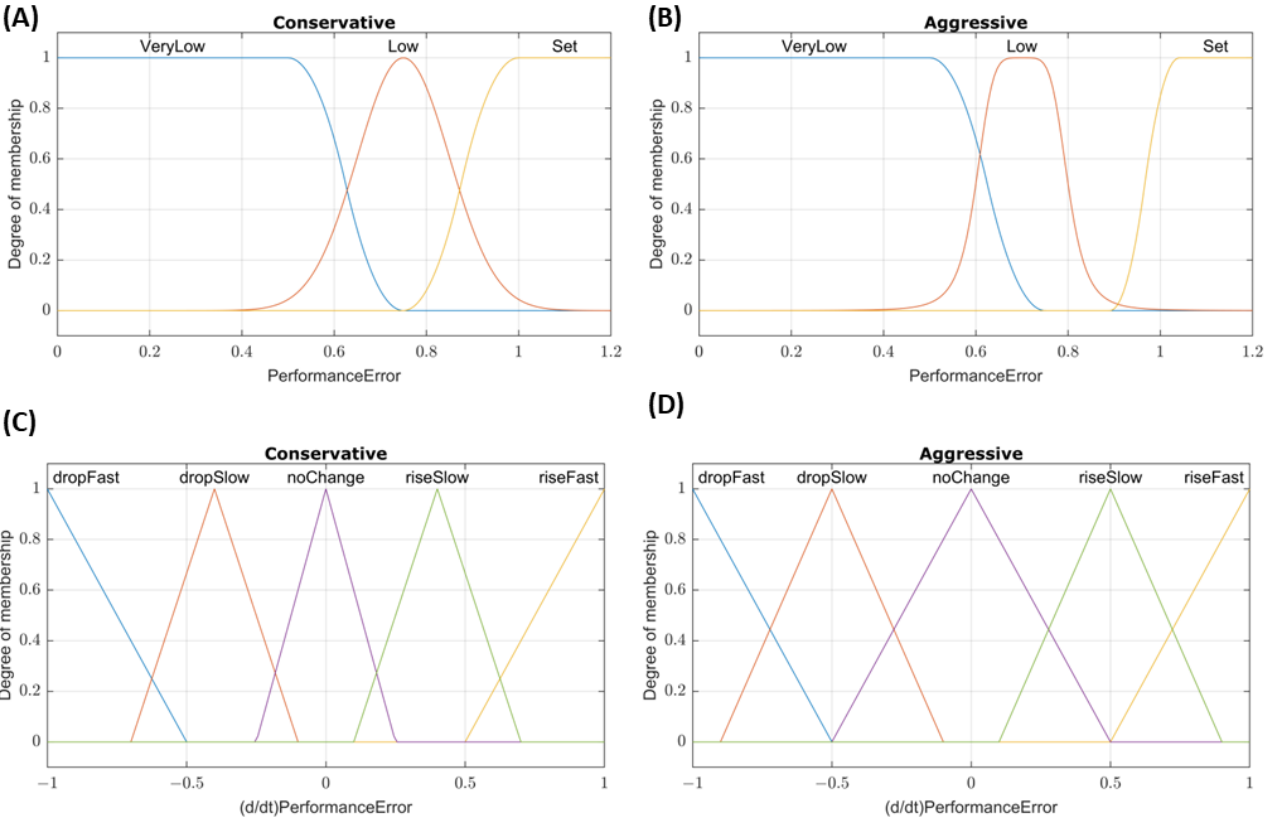
Figure 2. Membership function plots for DFL controllers . Plots of the PerformanceError and (d/dt) PerformanceError input membership functions for ( A , C ) conservative and ( B , D ) aggressive tuned dual-input fuzzy logic controllers, respectively.